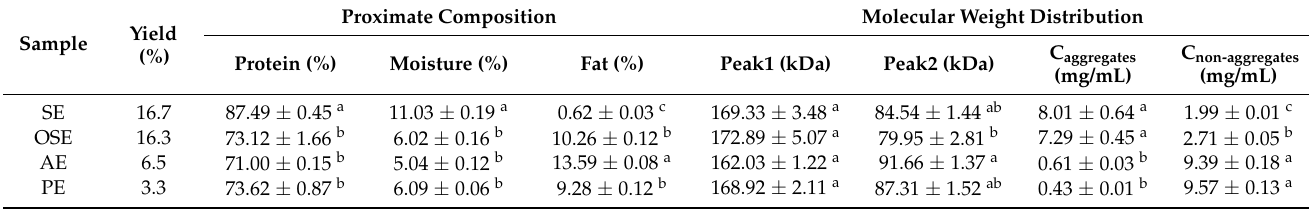
Table 1. Yield, proximate composition and molecular weight distribution of field muskmelon seeds protein extracted by different oil extraction